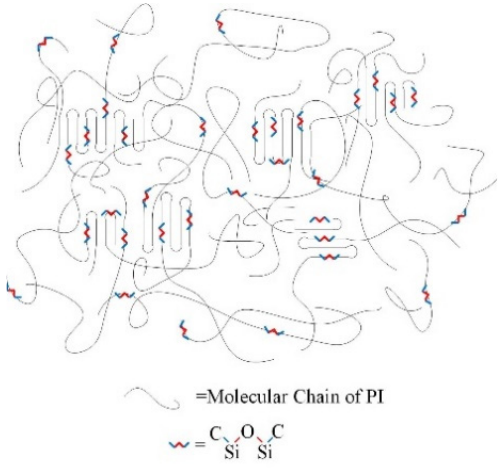
Figure 17. Structural model of modified materials.